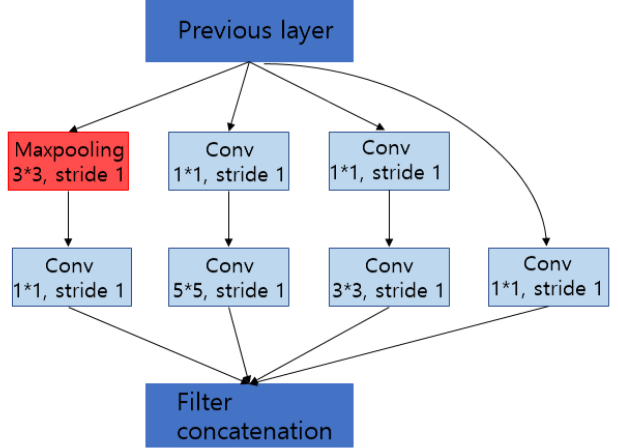
Figure 11. Inception module.